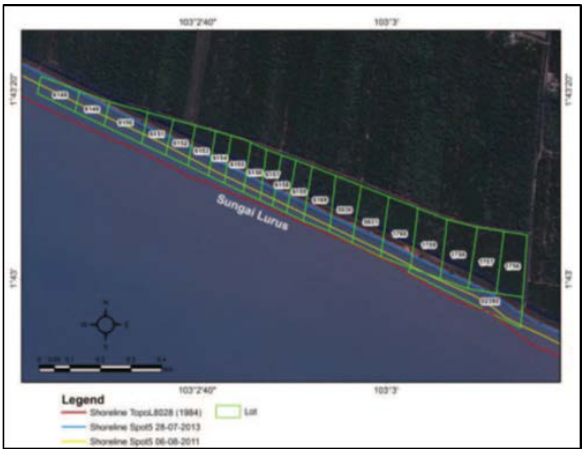
Figure 6. Impact Sea Level Rise on Shoreline Changes